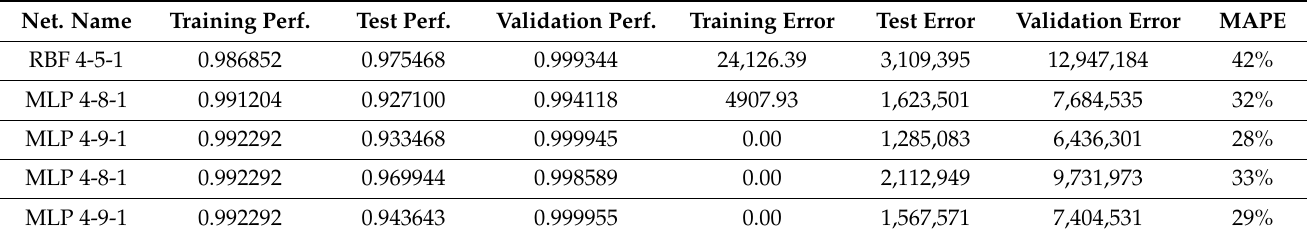
Table 7. Alternative multivariate models for predicting Y mining gross value added. Net. Name Training